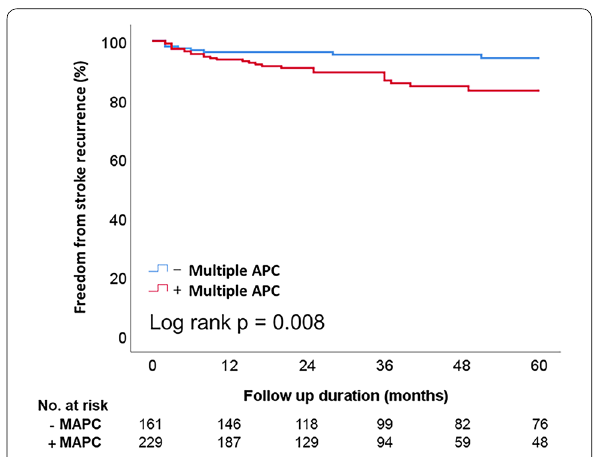
Fig. 1 Kaplan–Meier survival curves for stroke recurrence